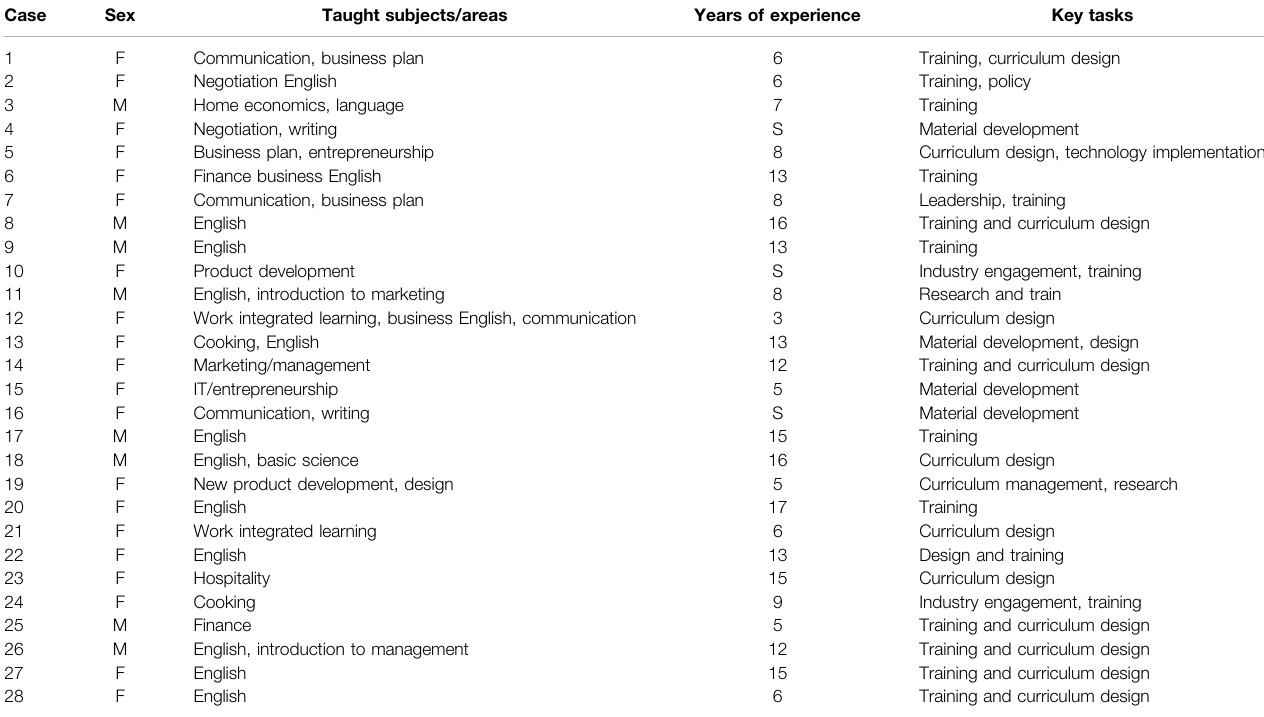
TABLE 1 | Details of participants/key